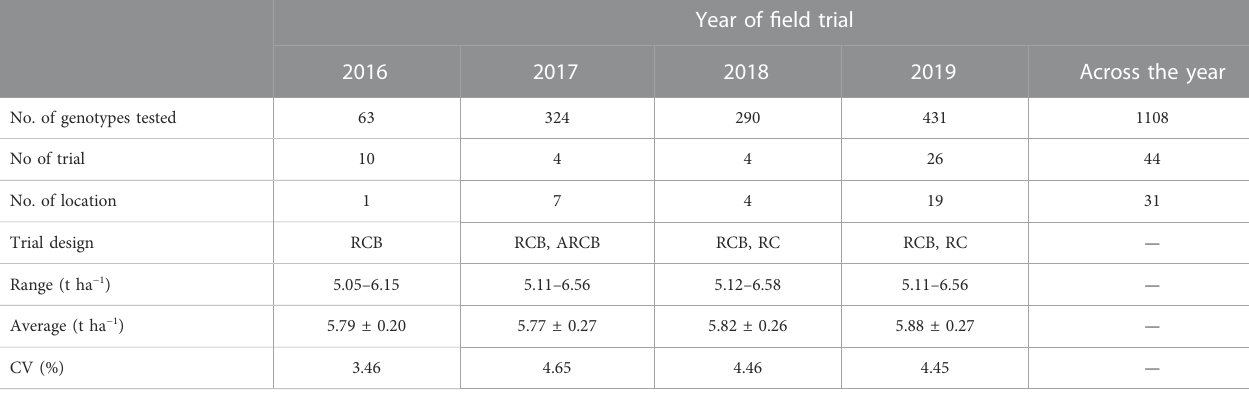
TABLE 1 Meta data and descriptive statistics of the analysis for the yield of 1108 individual breeding lines/varieties tested in 44 trials during Boro season of 2016 – 2019 under favorable ecosystems.